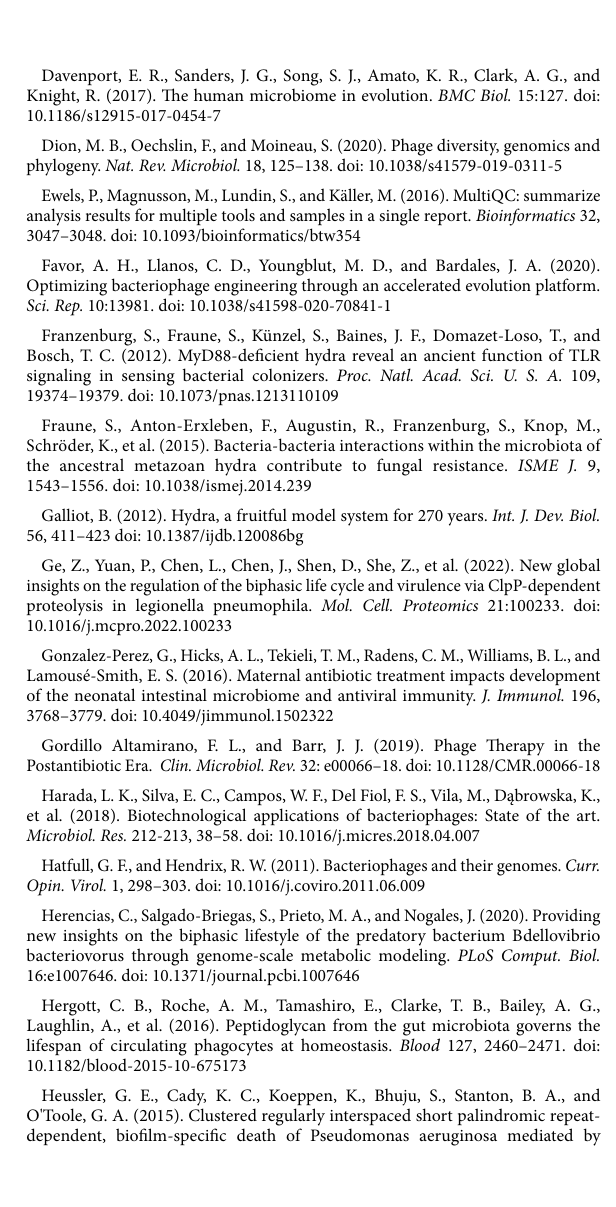
SUPPLEMENTARY FIGURE S1 Taxonomic Tree comparing the PCA1 phage to 200 related phages based on proteomic similarity. The left box indicates the viral family with Siphoviridae in orange, Myoviridae in green and Podoviridae in blue, while the right box indicates the class of bacterial hosts with Gammaproteobacteria in green, Actinobacteria in cyan,